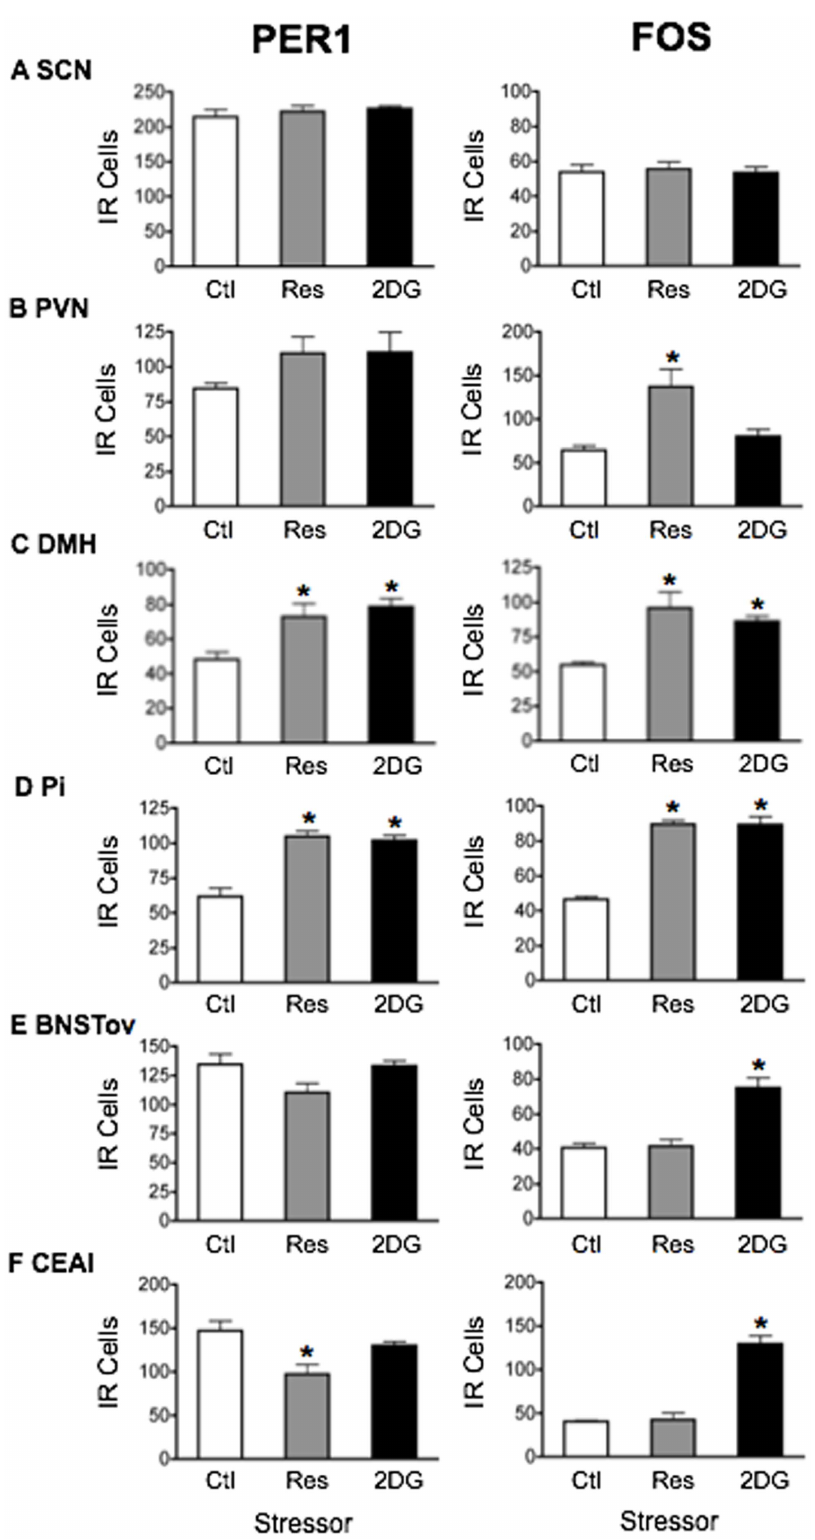
Figure 9. The effect of acute nighttime stress on PER1 and FOS expression. Rats were exposed to 30 min restraint or treatment with 250 mg/kg 2DG, administered during the nighttime at ZT14, and then killed at ZT15. Means 6 SEM of immunoreactive (IR) cells are shown, n =4 per group; * significant difference from corresponding control group, p , 0.05.